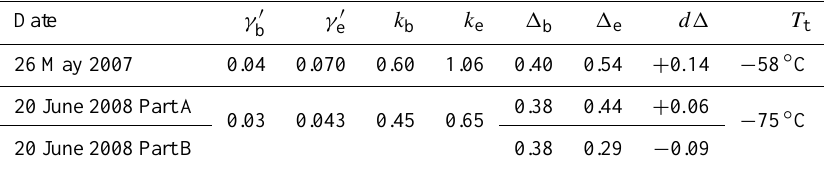
and γ 0 e , respectively), baseline and enhanced values of isotropic b